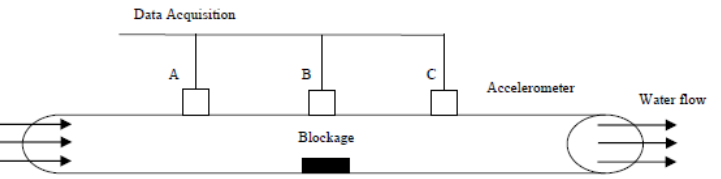
Figure 15. The experimental setup with accelerometers mounted on the external surface of the pipeline for the measurement of vibration signals. Reprinted under Creative Commons CC BY license [38].